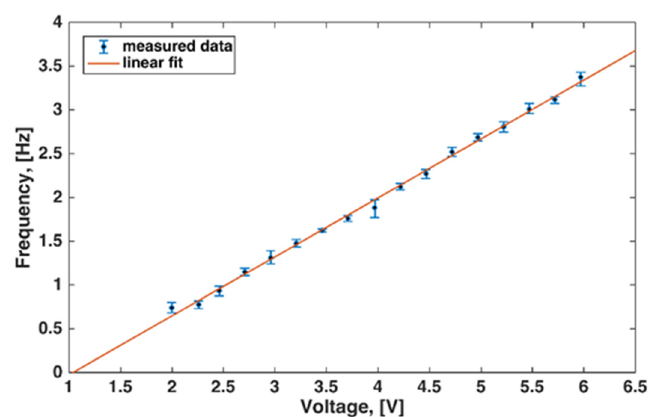
Figure 9. Linear relation between the voltage supplied to the motor and the tail beat frequency. Points are the means of 100 frequency readings. Error bars indicate maximal and minimal values.